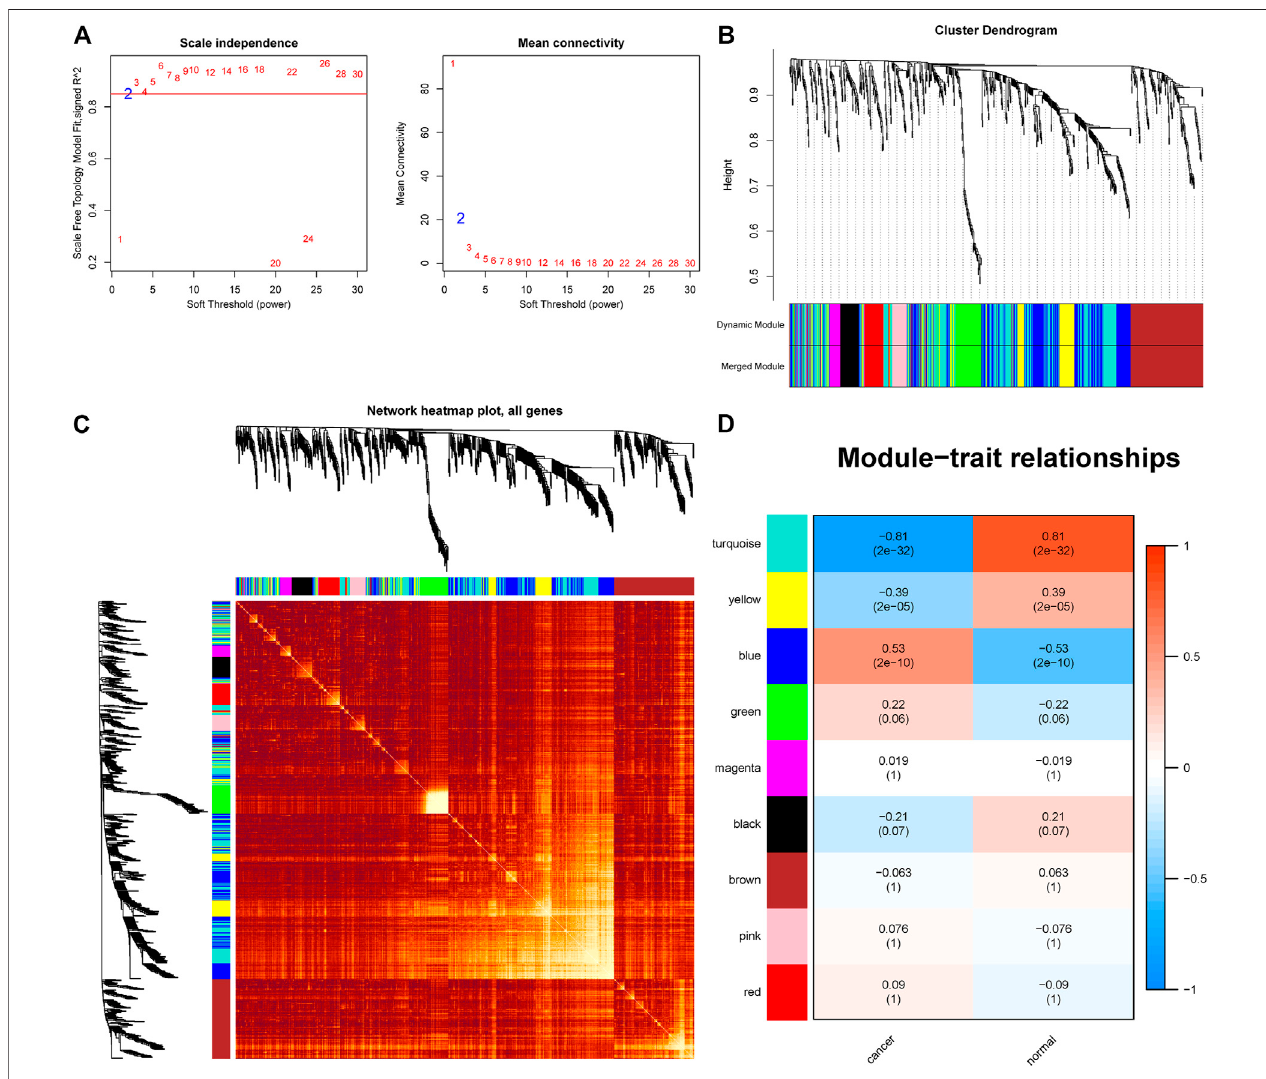
FIGURE7 | WGCNA identi fi cation oflung adenocarcinoma associated miRNA modules in GSE74190. (A) Soft-thresholdpower versus scale-freetopology model fi t index and mean connectivity. (B) Cluster dendrogram of the co-expression network modules. (C) Cluster dendrogram of the co-expression network modules. (D) Analysis of the miRNA relationship between lung adenocarcinoma and normal sample